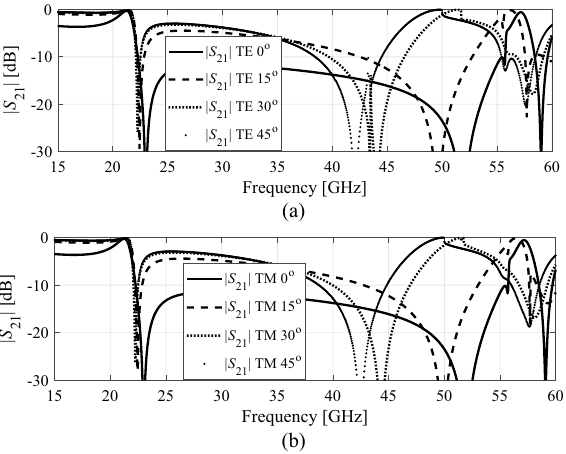
Figure 10. Design 2: ( a ) transmission coefficients for TE mode, ( b ) transmission coefficient for TM mode at different incidence